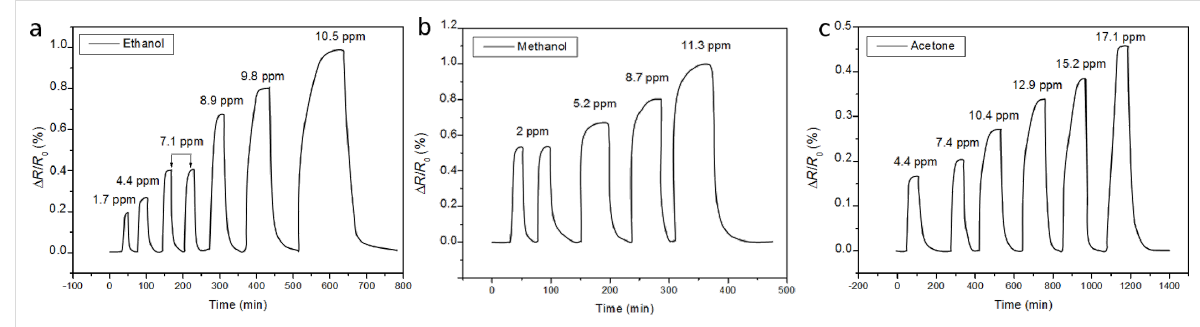
Figure 3: Pt-decorated MWCNTs sensor response to (a) ethanol, (b) methanol and (c) acetone vapours.